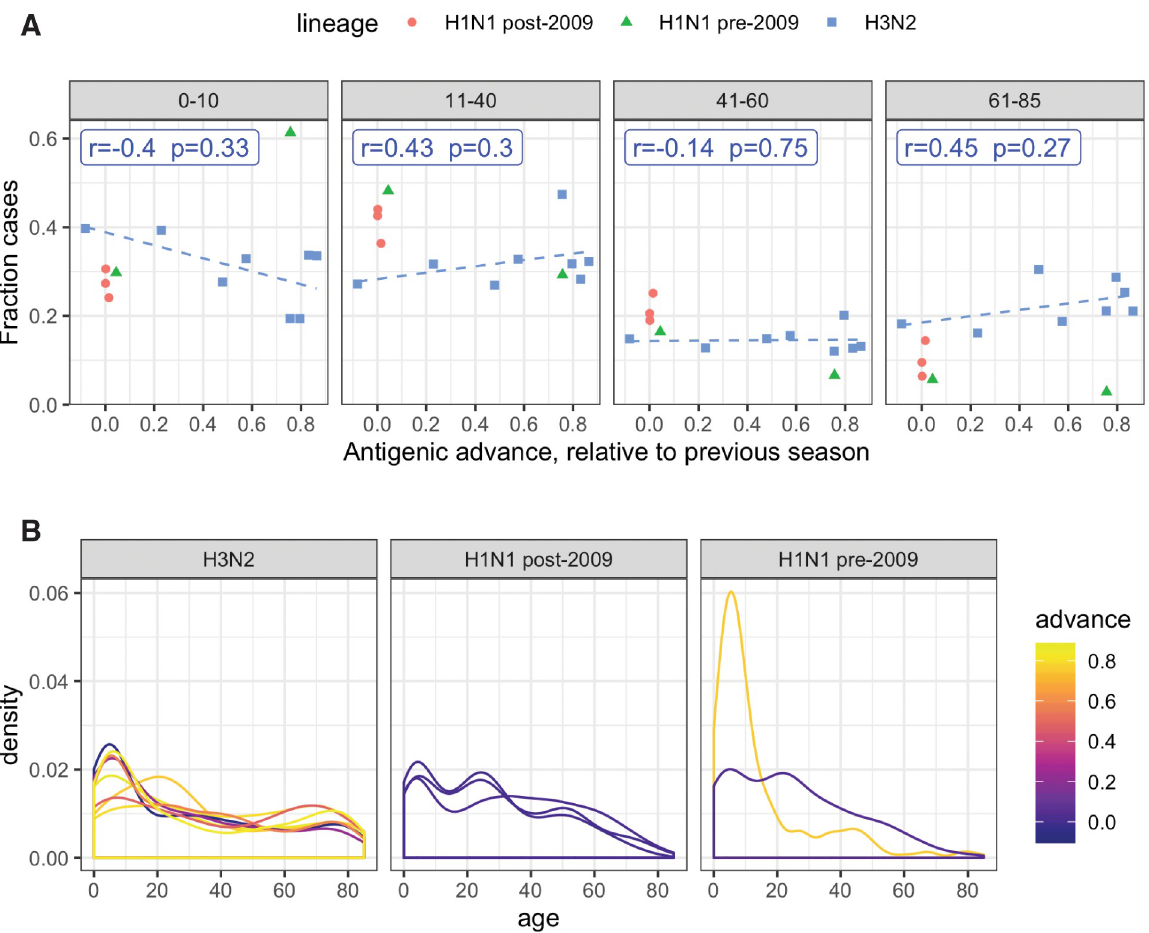
Fig 4. Effect of antigenic advance on age distribution. (A) Relationship between annual antigenic advance and the fraction of cases observed in children (0–10), or in adult age groups. Each data point represents a single influenza season in which at least 100 confirmed cases of a given subtype were observed. Blue label shows Spearman correlation between the fraction of H3N2 cases observed in each age group and annual antigenic advance. Blue dashes show linear trend fitted using lm() in R. (B) Season-specific age distributions of cases, colored by antigenic advance since the previous